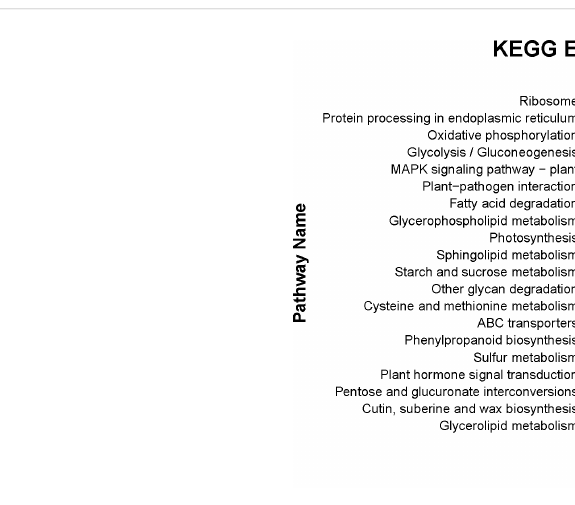
FIGURE 4 Top twenty KEGG pathways enrichment of